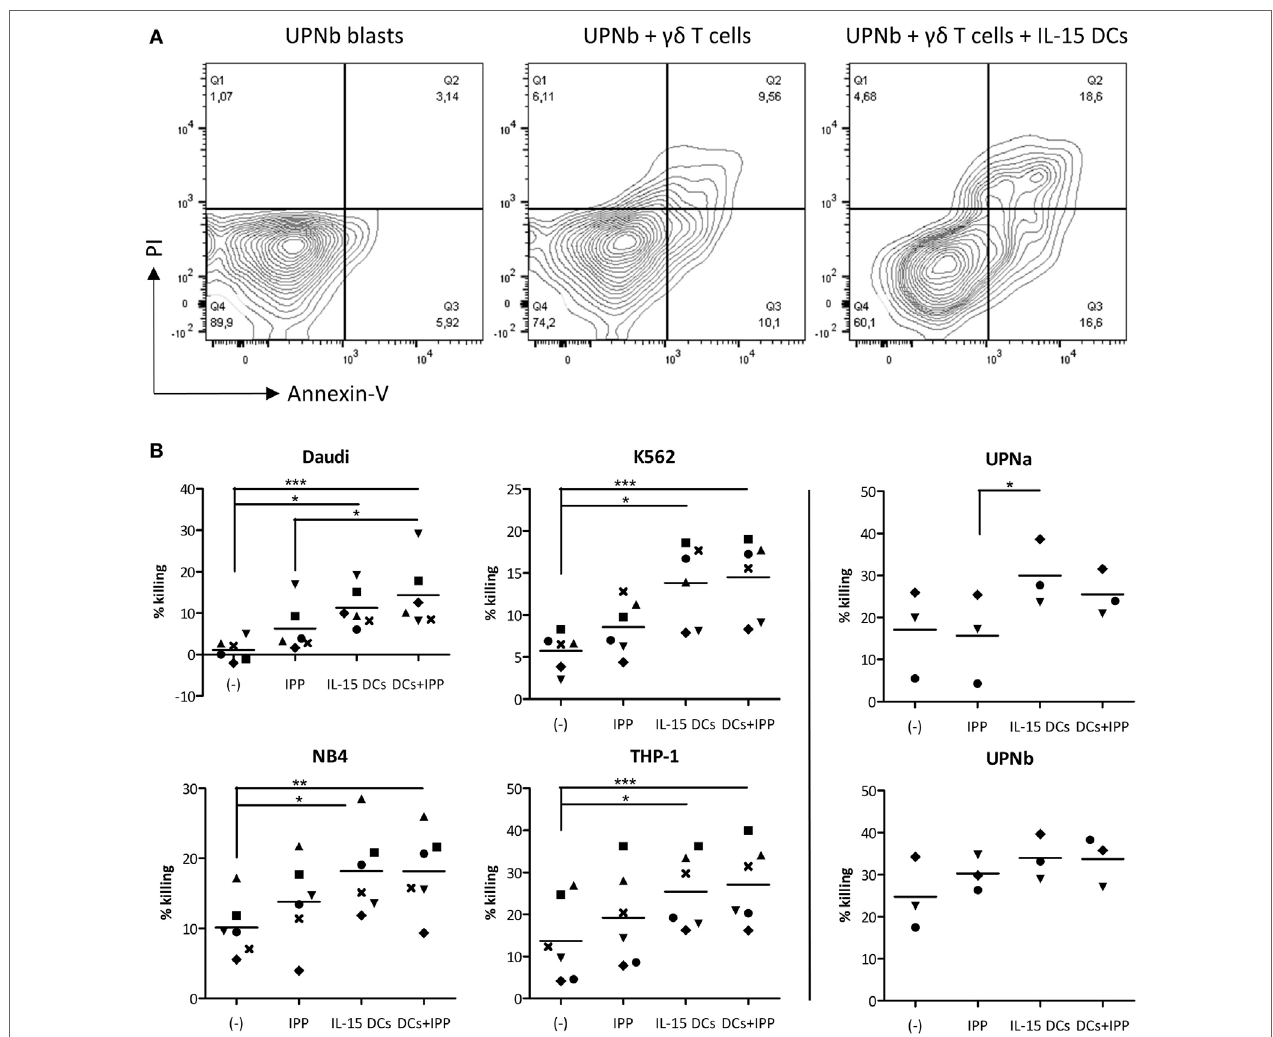
FigUre 4 | The cytotoxic capacity of γδ T cells is radically increased by IL-15 dendritic cells (DCs). (a) Representative example of primary acute myeloid leukemia blast killing (UPNb) from one out of three donors. (B) Cytotoxicity was determined of γδ cell ± IL-15 DC (co-)cultures with or without isopentenyl pyrophosphate after 24–36 hours. Unstimulated γδ T cells ( − ) were used to define basal killing capacity. Target cells were added at an E:T ratio of 2:1. Percentage tumor cell killing was ascertained by Annexin-V/PI staining after 4 hours and calculated using the formula specified in Section “Materials and Methods.” Donors are represented by unique symbols. Friedman test with Dunn’s Multiple Comparison Test. *** p < 0.001, ** p < 0.01, and * p <